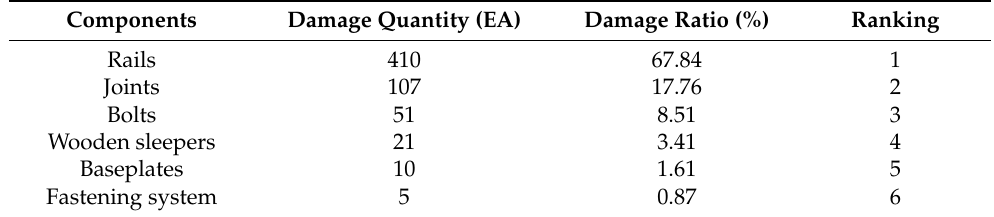
Table 4. Ratios of damage by